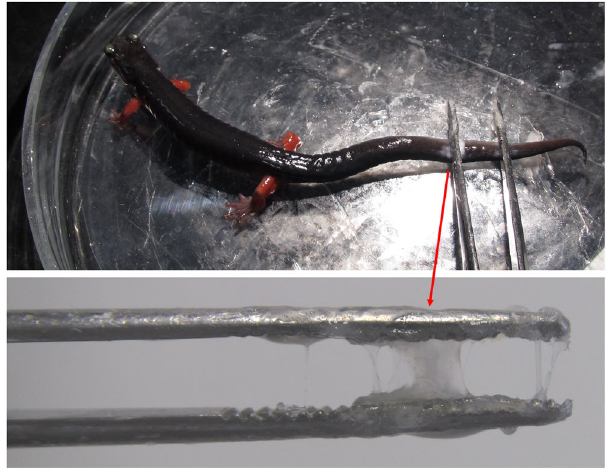
Figure 6. Isolated glue of Plethodon shermani , sticking to the metal